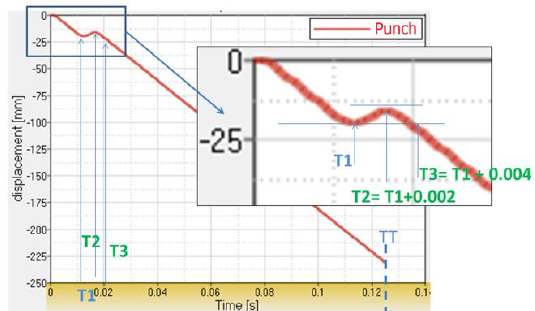
Figure 7. Input timing definition on stepwise curve.